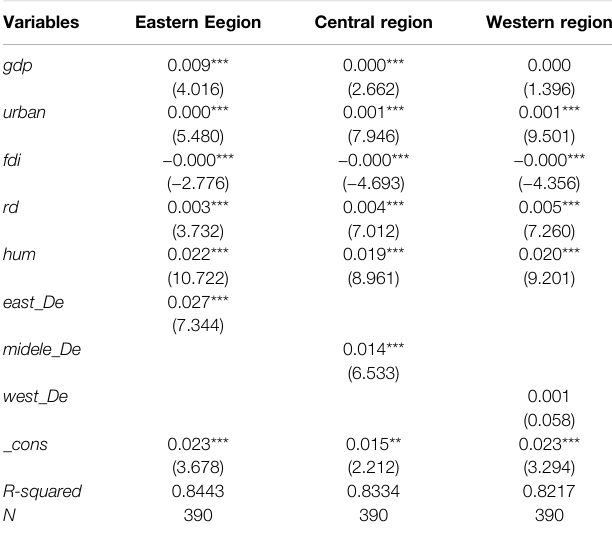
TABLE 12 | Regional heterogeneity regression